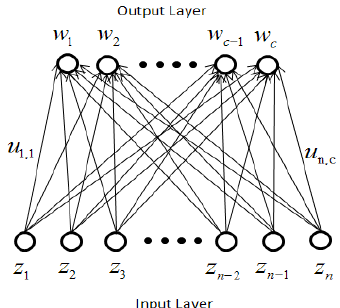
Figure 2. The competitive learning neural network